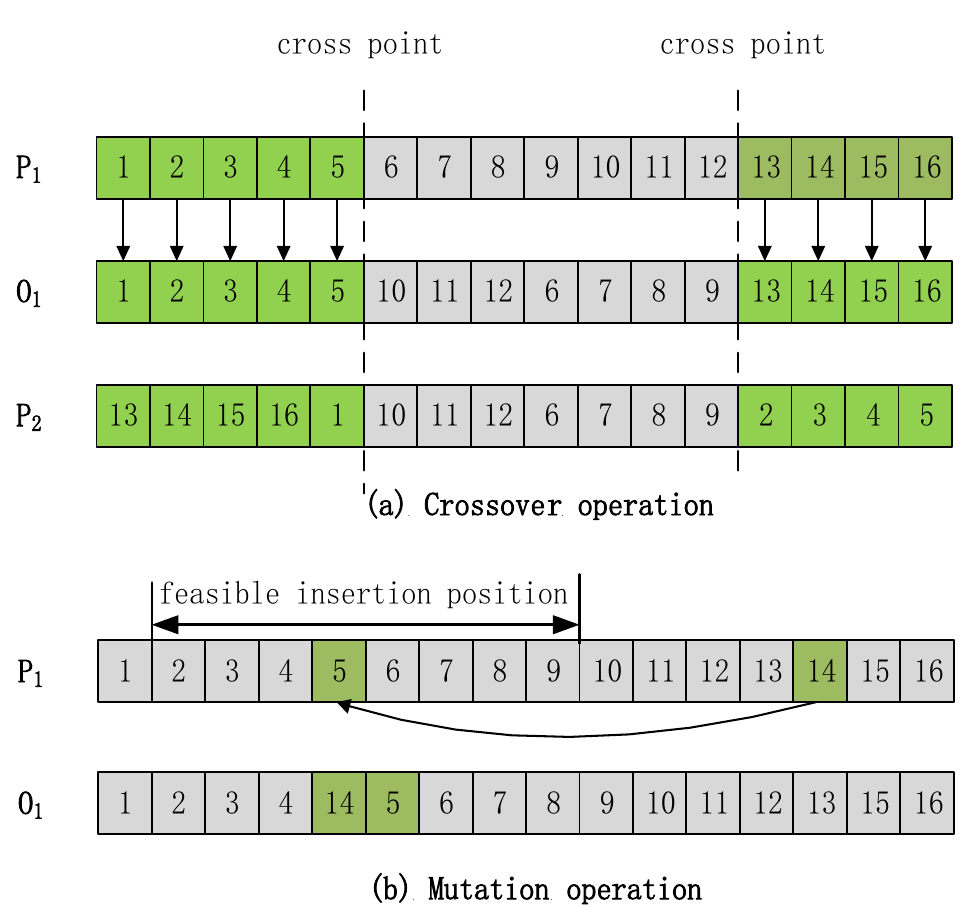
Figure 5. Sequence substring genetic